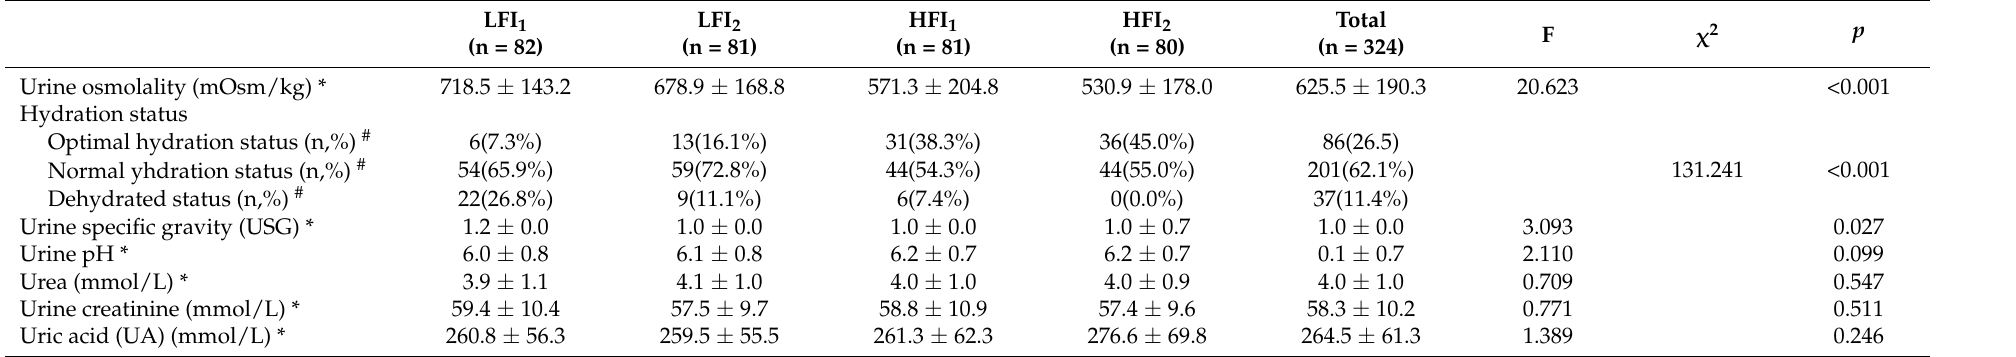
Table 4. Urine indexes for participants with different TFI